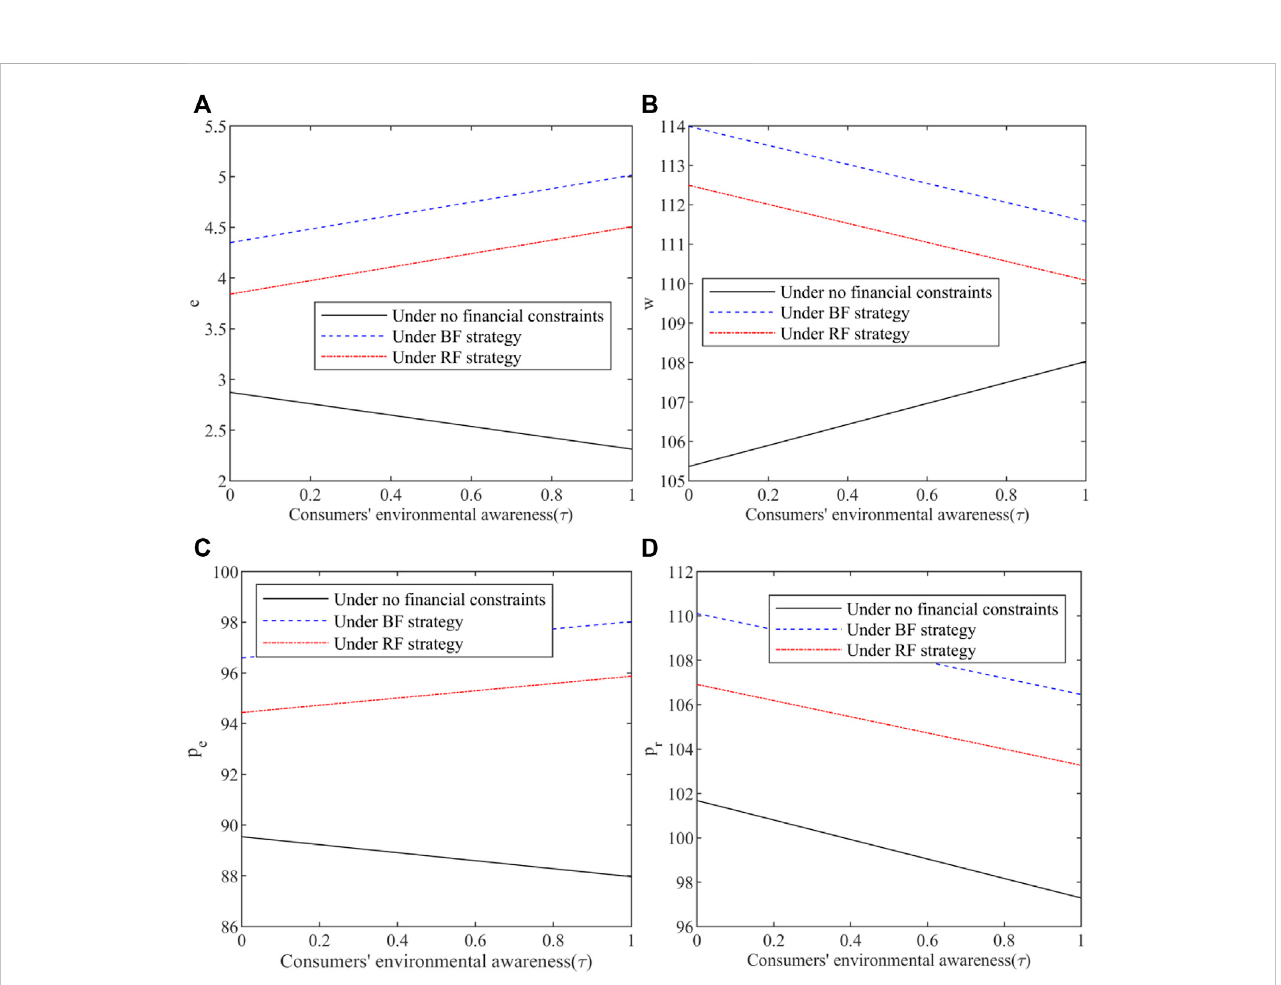
FIGURE 10 (A) Impact of consumers ’ environmental awareness on fresh-keeping efforts (B) Impact of consumers ’ environmental awareness on wholesale prices in the distribution channels. (C) Impact of consumers ’ environmental awareness on sales prices in the direct sales channels (D) Impact of consumer environmental awareness on sales prices in the distribution